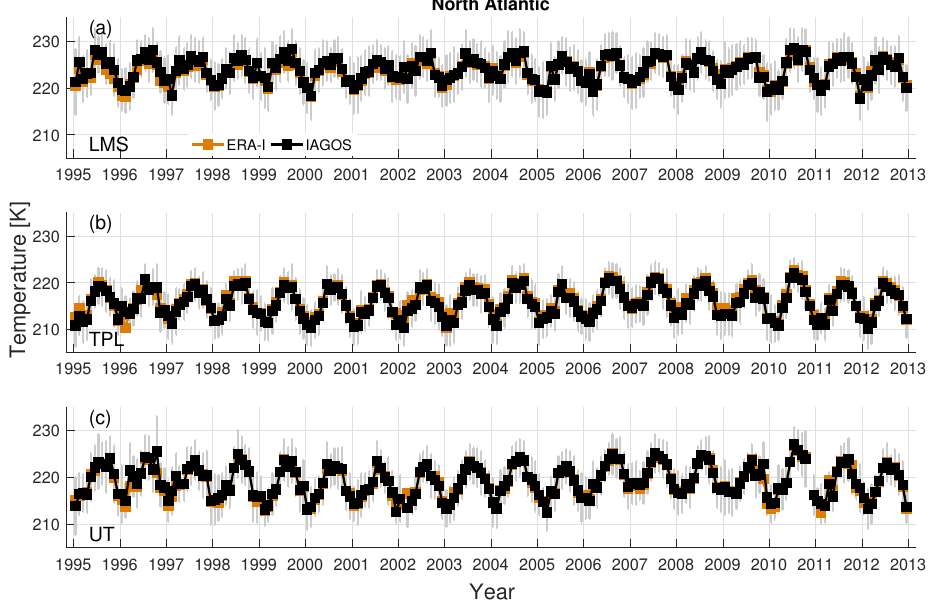
Figure 6. Temperature time series of IAGOS observations (black) and ERA-I (orange) for the (a) lowermost stratosphere, (b) tropopause layer, and (c) upper troposphere over the North Atlantic region. The grey lines show the SD (1 σ ) of the mean using the IAGOS observations for each